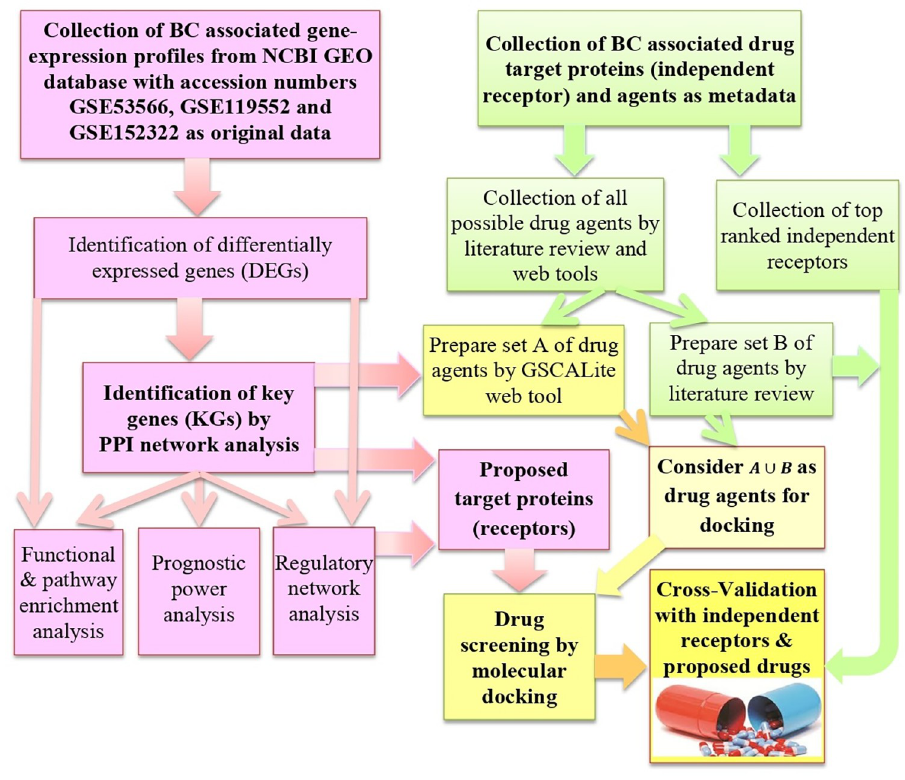
Fig 1. The pipeline of this